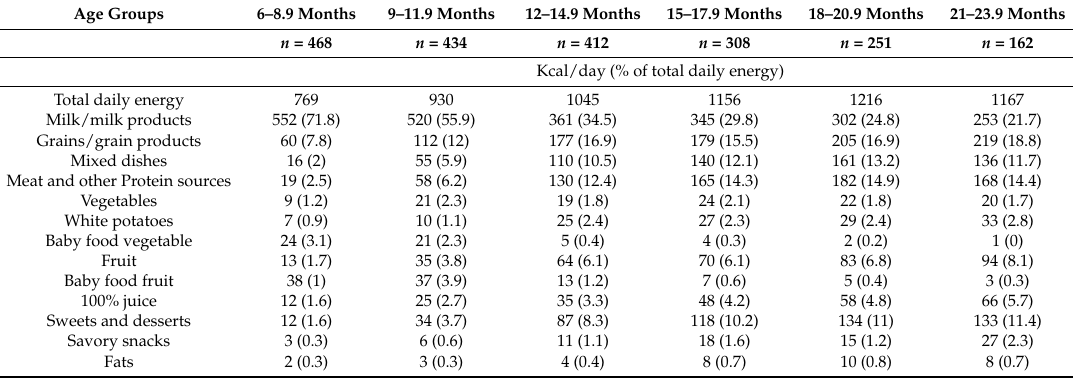
Table 1. Food sources of energy (calories per capita per day) from major food groups among children 6–23.9 months: FITS